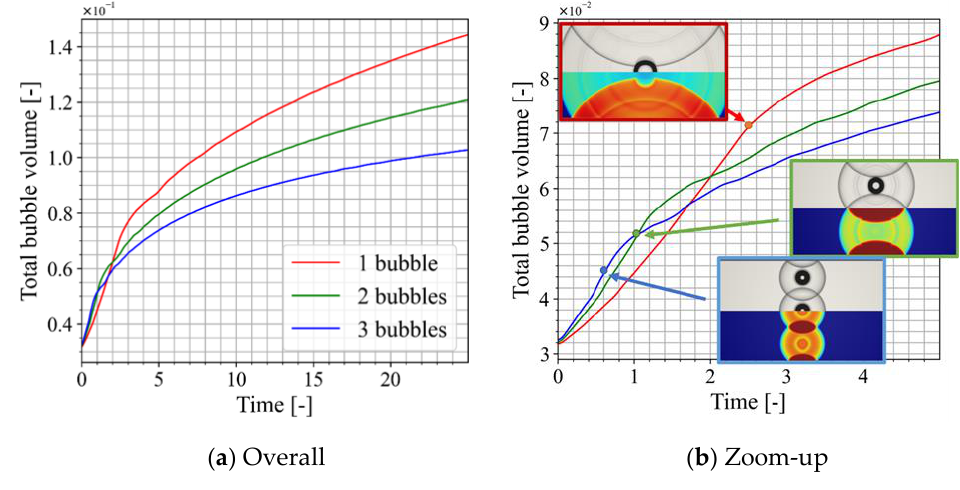
Figure 13. Time history of the total bubble volume. Table 6. Times when the pressure waves first contacted the bubble